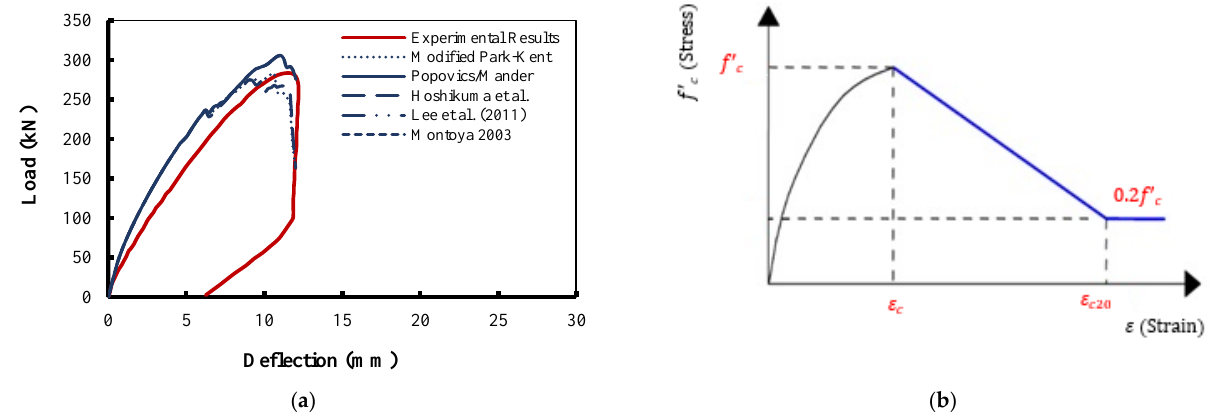
Figure 4. Concrete Compression Post-Peak Response: ( a ) Comparison between Concrete Compres- sion Post-Peak Models Available in VecTor2; ( b ) Concrete Modified Park–Kent Pre-Peak Model